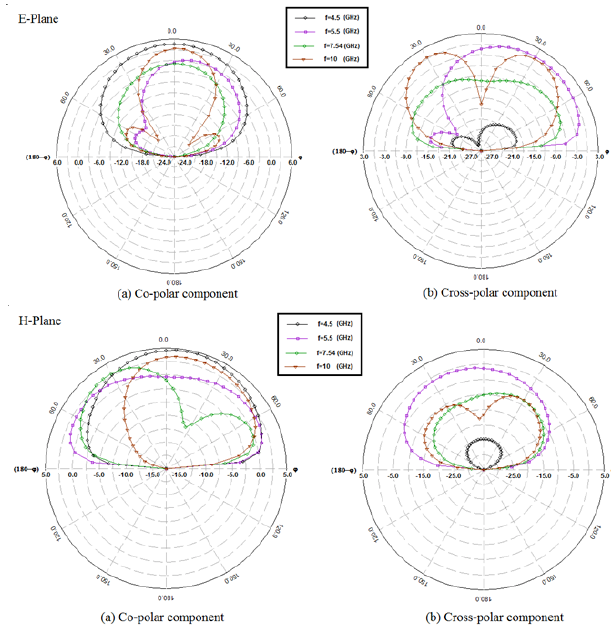
Figure 7. Radiation patterns of the proposed quadruple-band antenna (a) at 4.5 GHz, (b) at 5.5 GHz, (c) at 7.54 GHz and, (d) at 10.07 GHz.